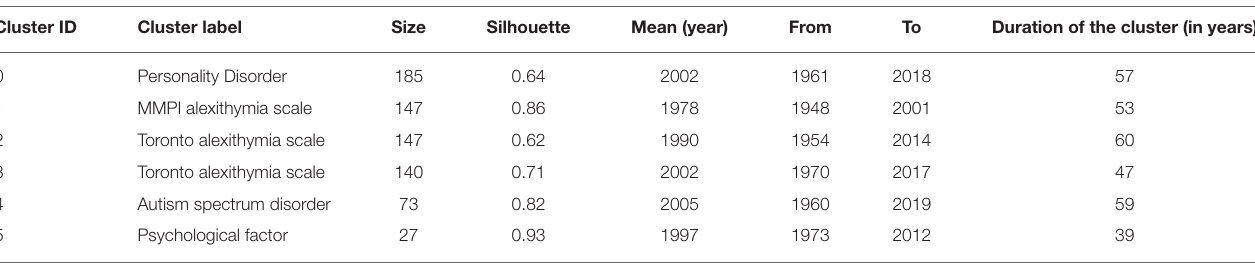
TABLE 1 | Clusters computed via Document co-citation Analysis (DCA). Cluster